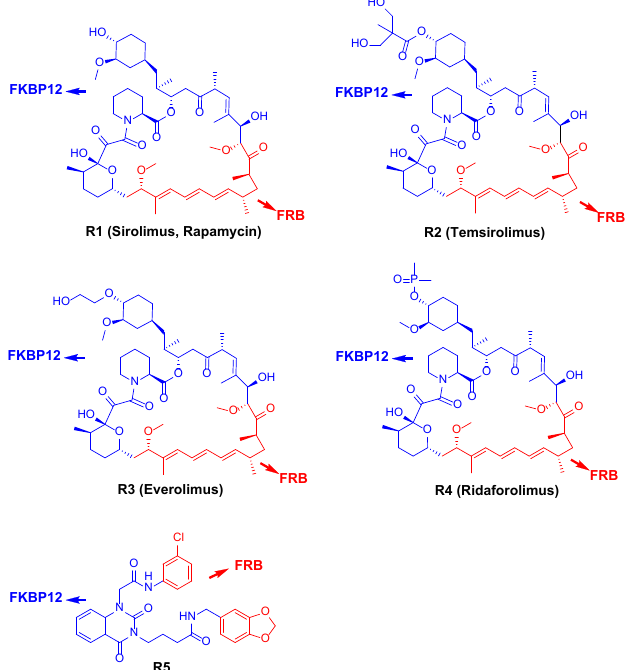
Figure 3. Structures of allosteric inhibitors of mTOR and representations showing the binding mode of them with FKBP12 (blue) and FRB (red). R1 - R4 : rapamycin and its derivatives; R5 : non-rapalog allosteric inhibitor.